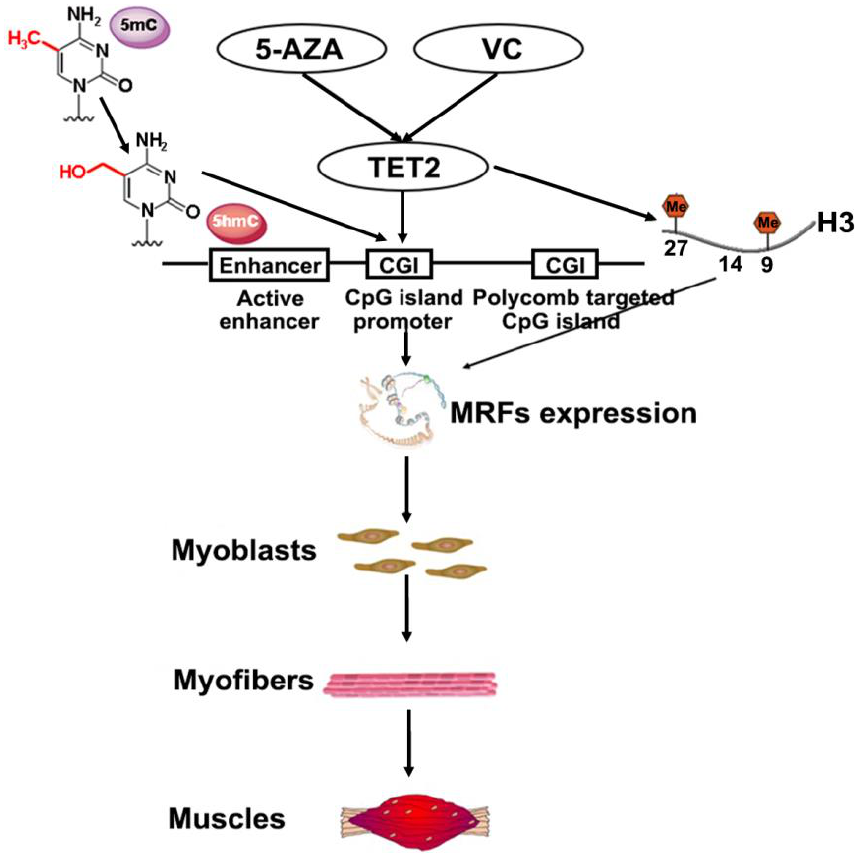
Figure 7. Model of TET2 in regulating myoblast differentiation.